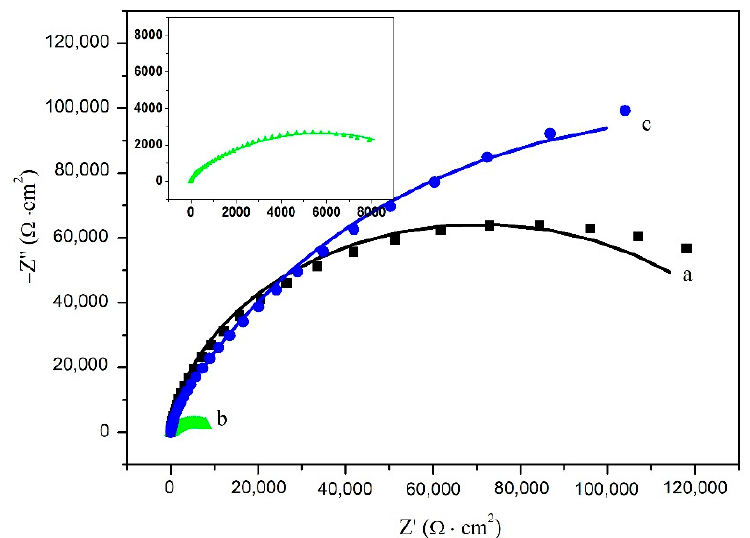
Figure 12. Nyquist plots of the carbon steel without cathodic protection (a: 0 day; b: 21 days) and with cathodic protection (c: 21 days) immersed in NSCS.